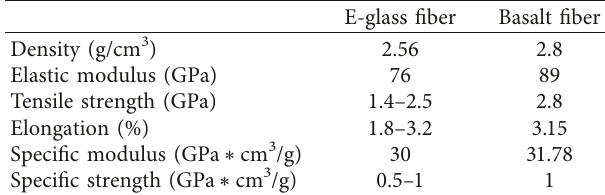
Table 1: Mechanical properties of E-glass fiber and basalt